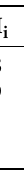
Table 3. WTG participation index (PI i ) of interarea modes for the case with the penetration level 50.17% in the NETS area.